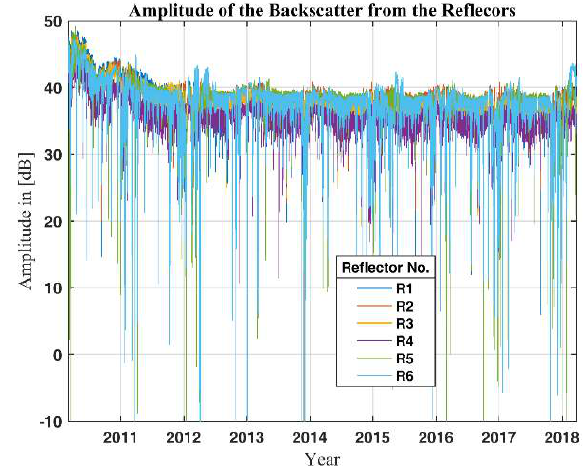
Figure 5. Time-Amplitude plot showing the amplitude of the reflected energy from the six reflectors as a function of time. Most of the attenuation is in the winter-months, which for this part of Norway and this elevation is from November to March.